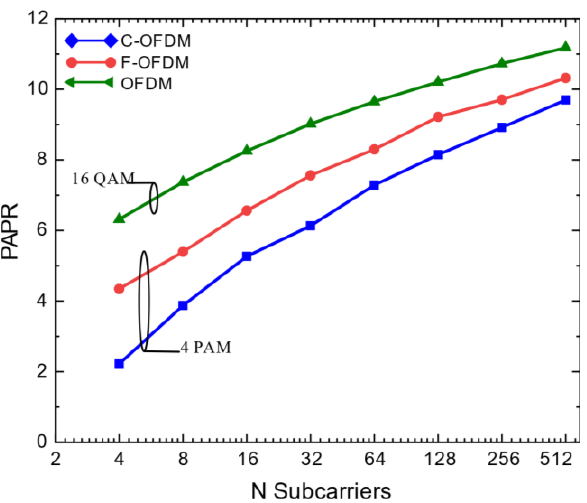
Figure 14. The measured PAPR for C-OFDM, F-OFDM and OFDM.